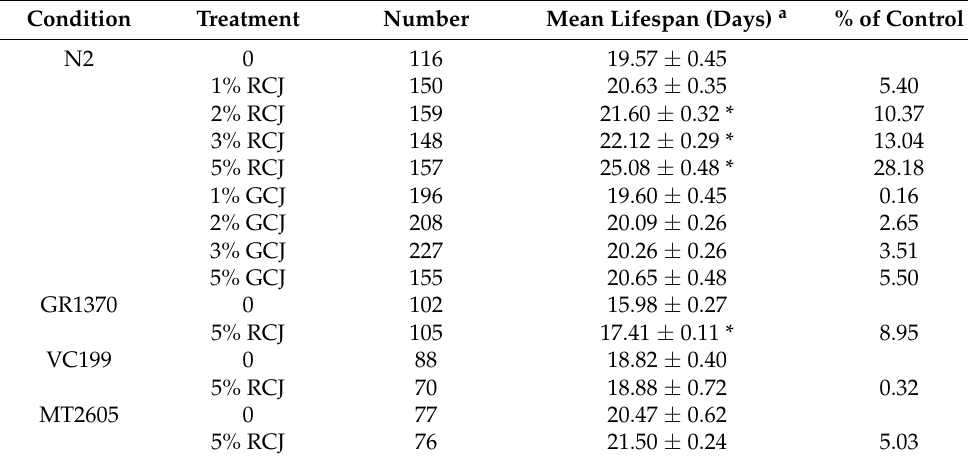
Table 3. Statistical analysis of the lifespan of C. elegans .